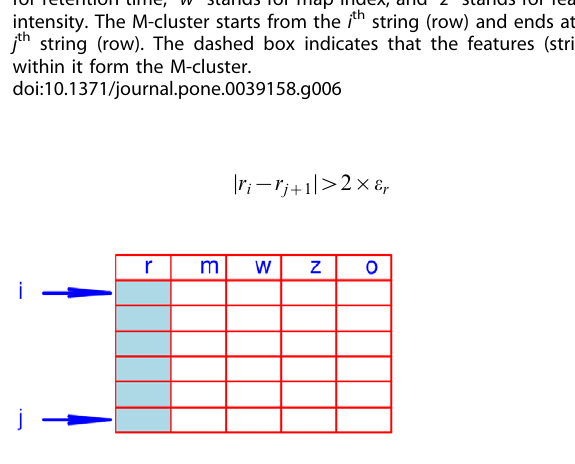
Figure 7. R-cluster formation in an h -list. The first column stores retention time values of all features in the h -list. In addition to four columns, we have introduced the ‘‘o’’ column for indexing the S list.